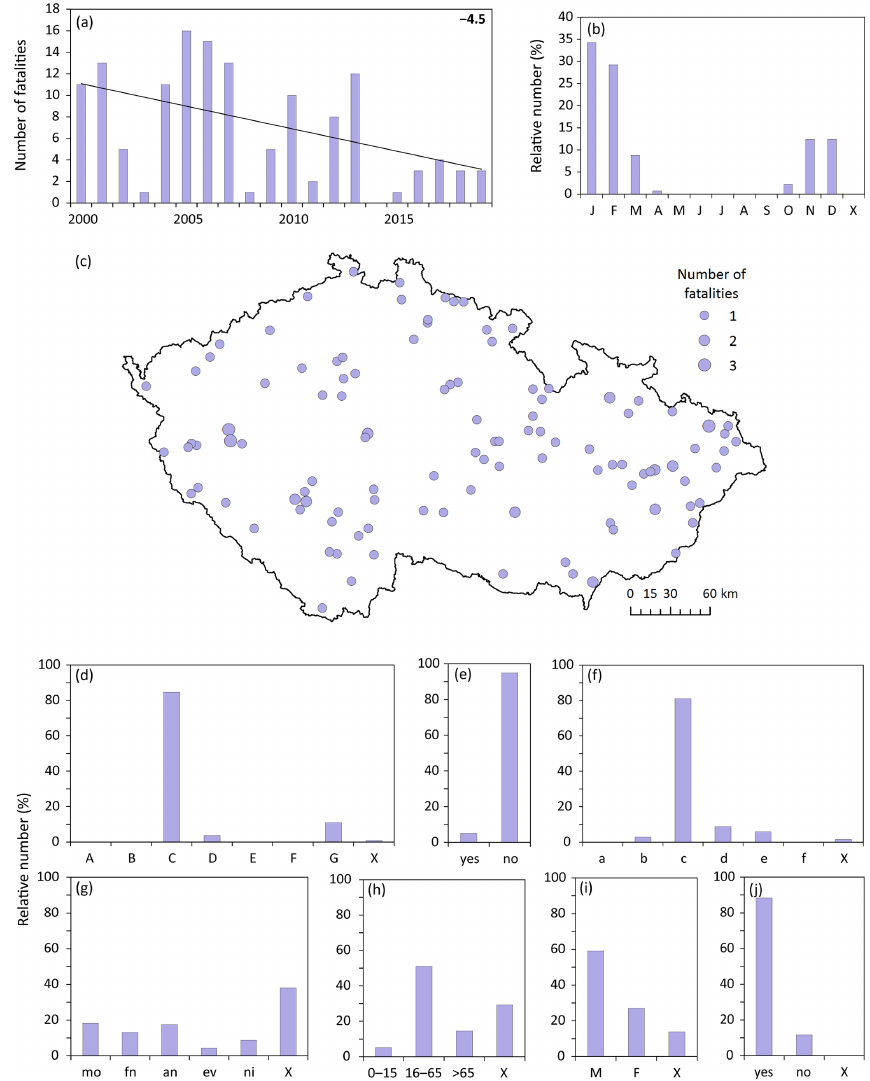
Figure 5. Characteristics of snow-related fatalities in the Czech Republic during the 2000–2019 period: (a) fluctuation with linear trend (top right, fatalities/10 years), (b) annual variation, (c) spatial distribution (12 fatalities lack exact location), (d) cause of death, (e) type of fatality, (f) place of death, (g) part of the day, (h) age, (i) sex, (j) behaviour. For explanation of symbols and abbreviations see Fig.